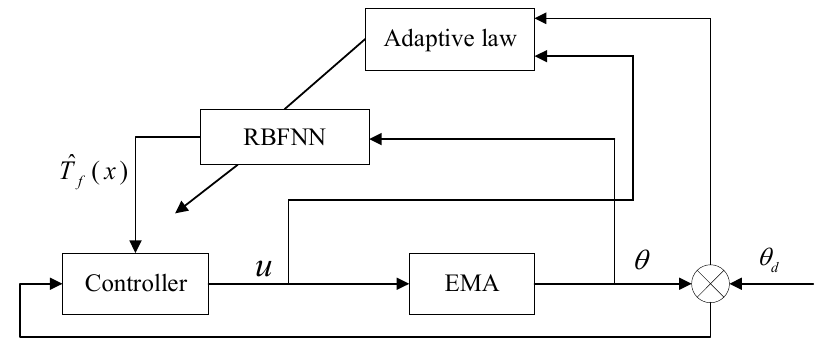
Figure 3. RBF − NN ASMC block diagram. Figure 3. RBF-NN ASMC block